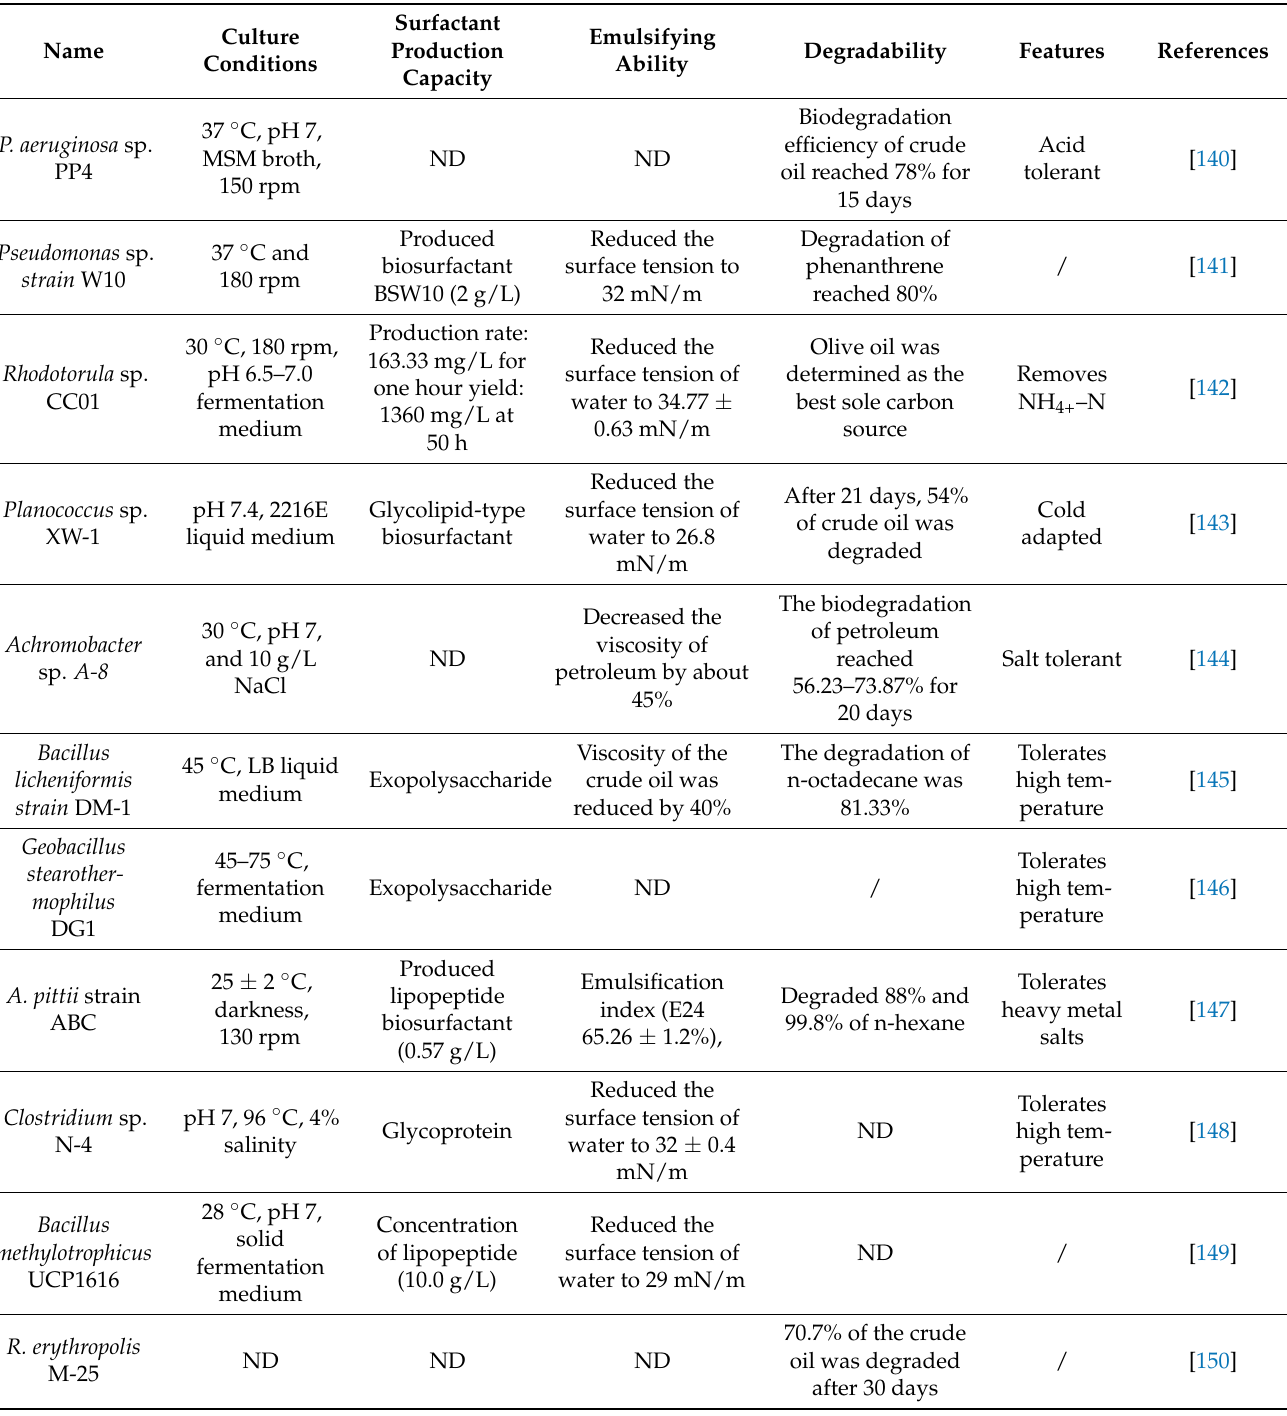
Table 3. Surfactant-producing bacteria isolated and identified from the environment in recent